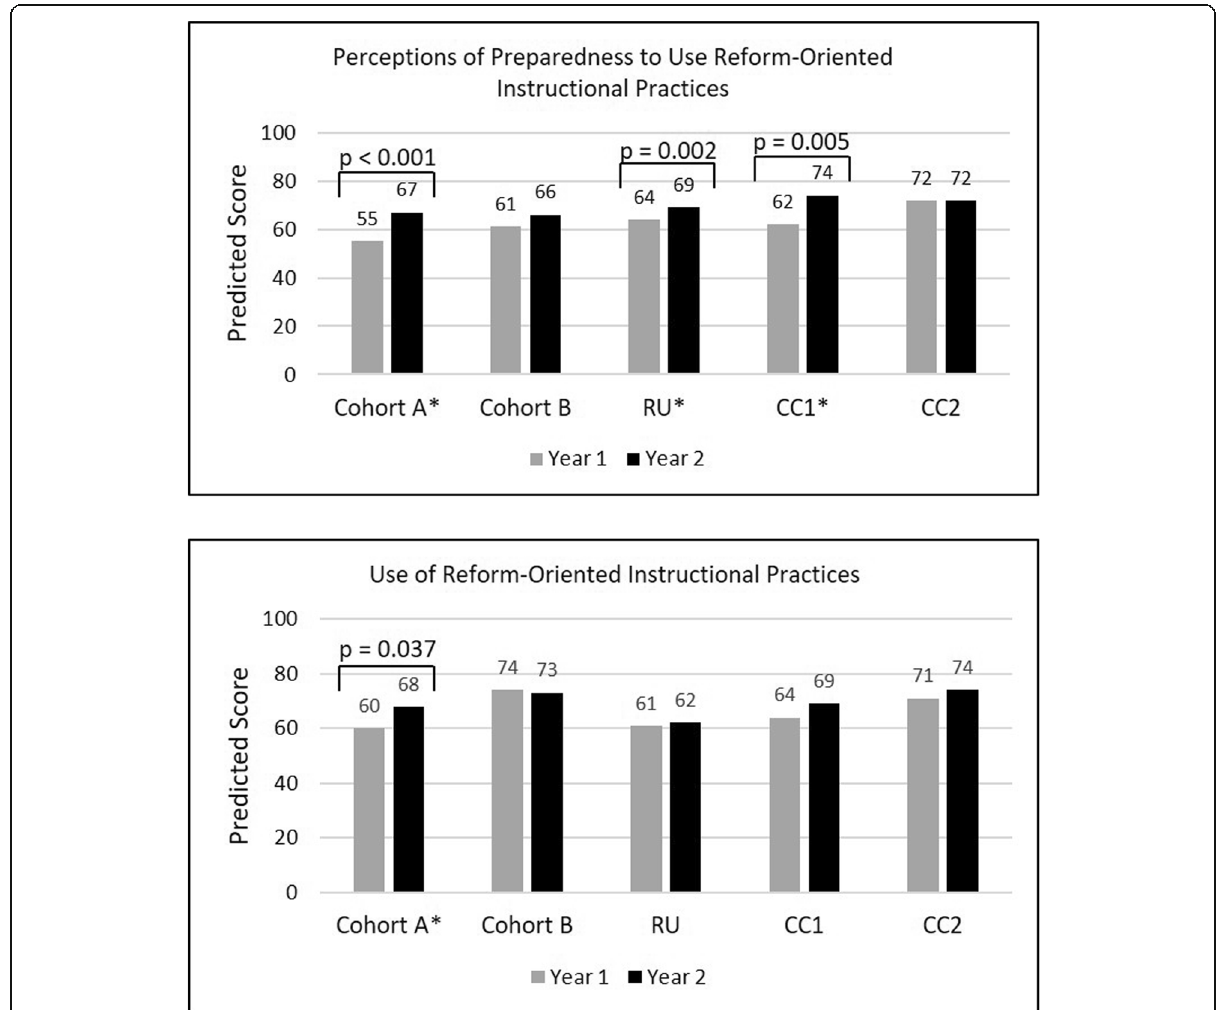
Fig. 1 External evaluation survey findings from perceptions of preparedness and use of practices questions for years 1 and 2. *Indicates a statistically significant difference ( p